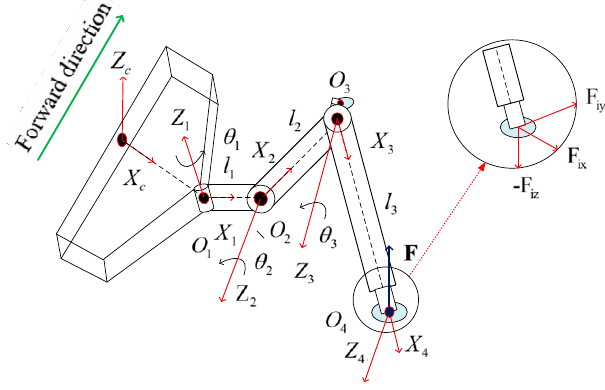
Figure 1. MDH model of a single leg of the robot. Table 1. Description of parameters in Figure 1.